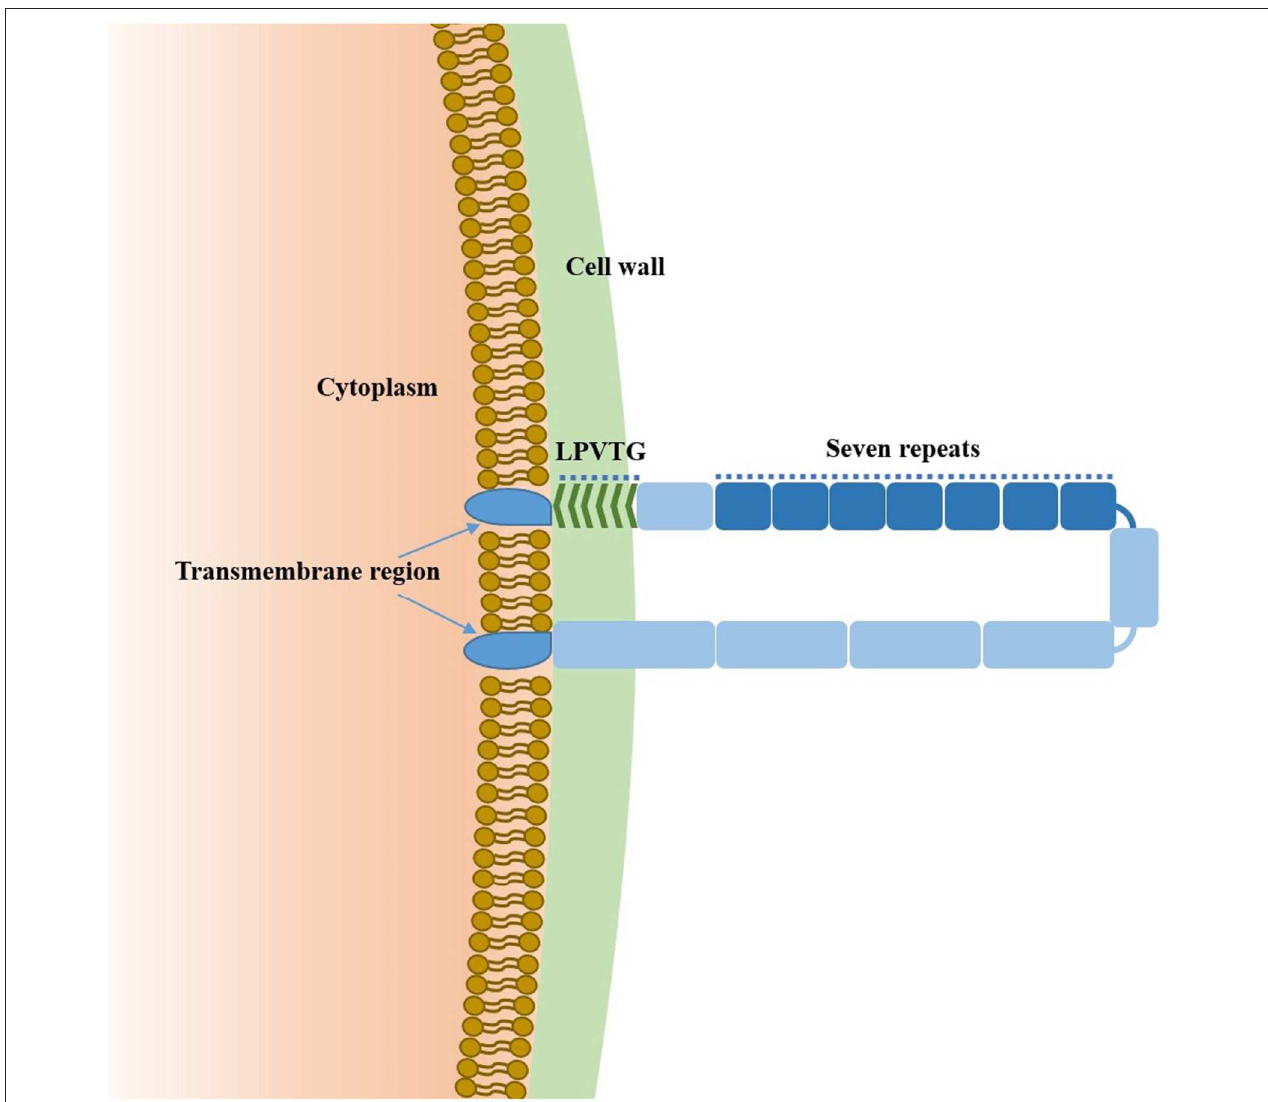
FIGURE 1 | Model of Sao-M protein from S . suis 2